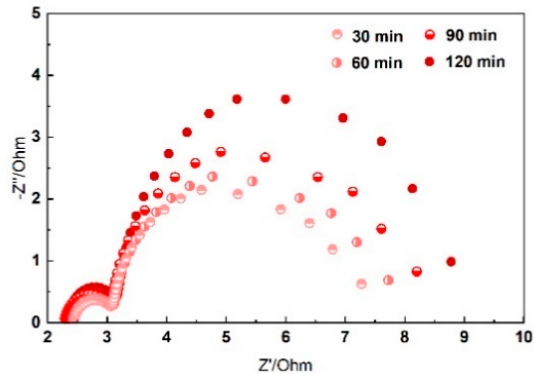
Figure 6. Impedance spectra presented in Nyquist plots of Al-air batteries as a function of time.